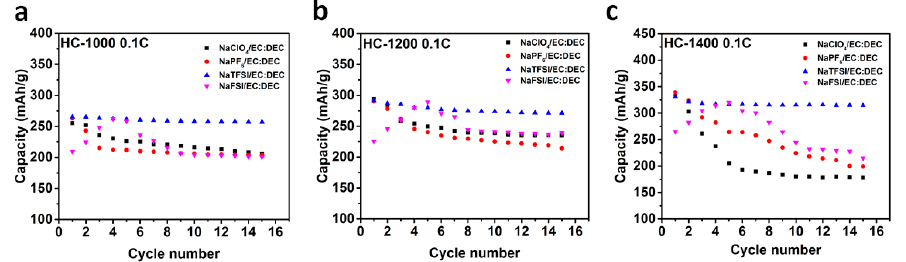
Figure 4. Cycle performance. Cycle performance of HC samples at a current rate of 0.1 C with different electrolytes: ( a ) HC-1000; ( b ) HC-1200; and ( c ) HC-1400.